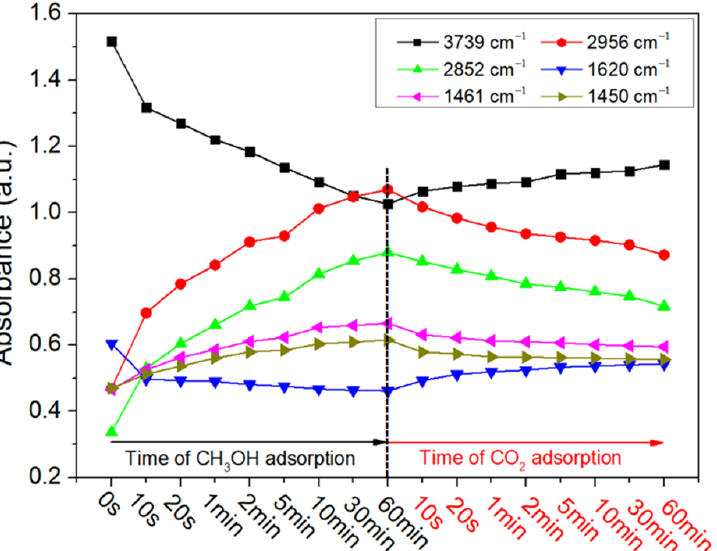
Figure 5. Infrared peak intensities of the different functional groups for Zr-SBA-15 taken during the experiments shown in Supplementary Figures S2 and S3. Peaks intensities are normalized from 3739 to 1450 cm − 1 .